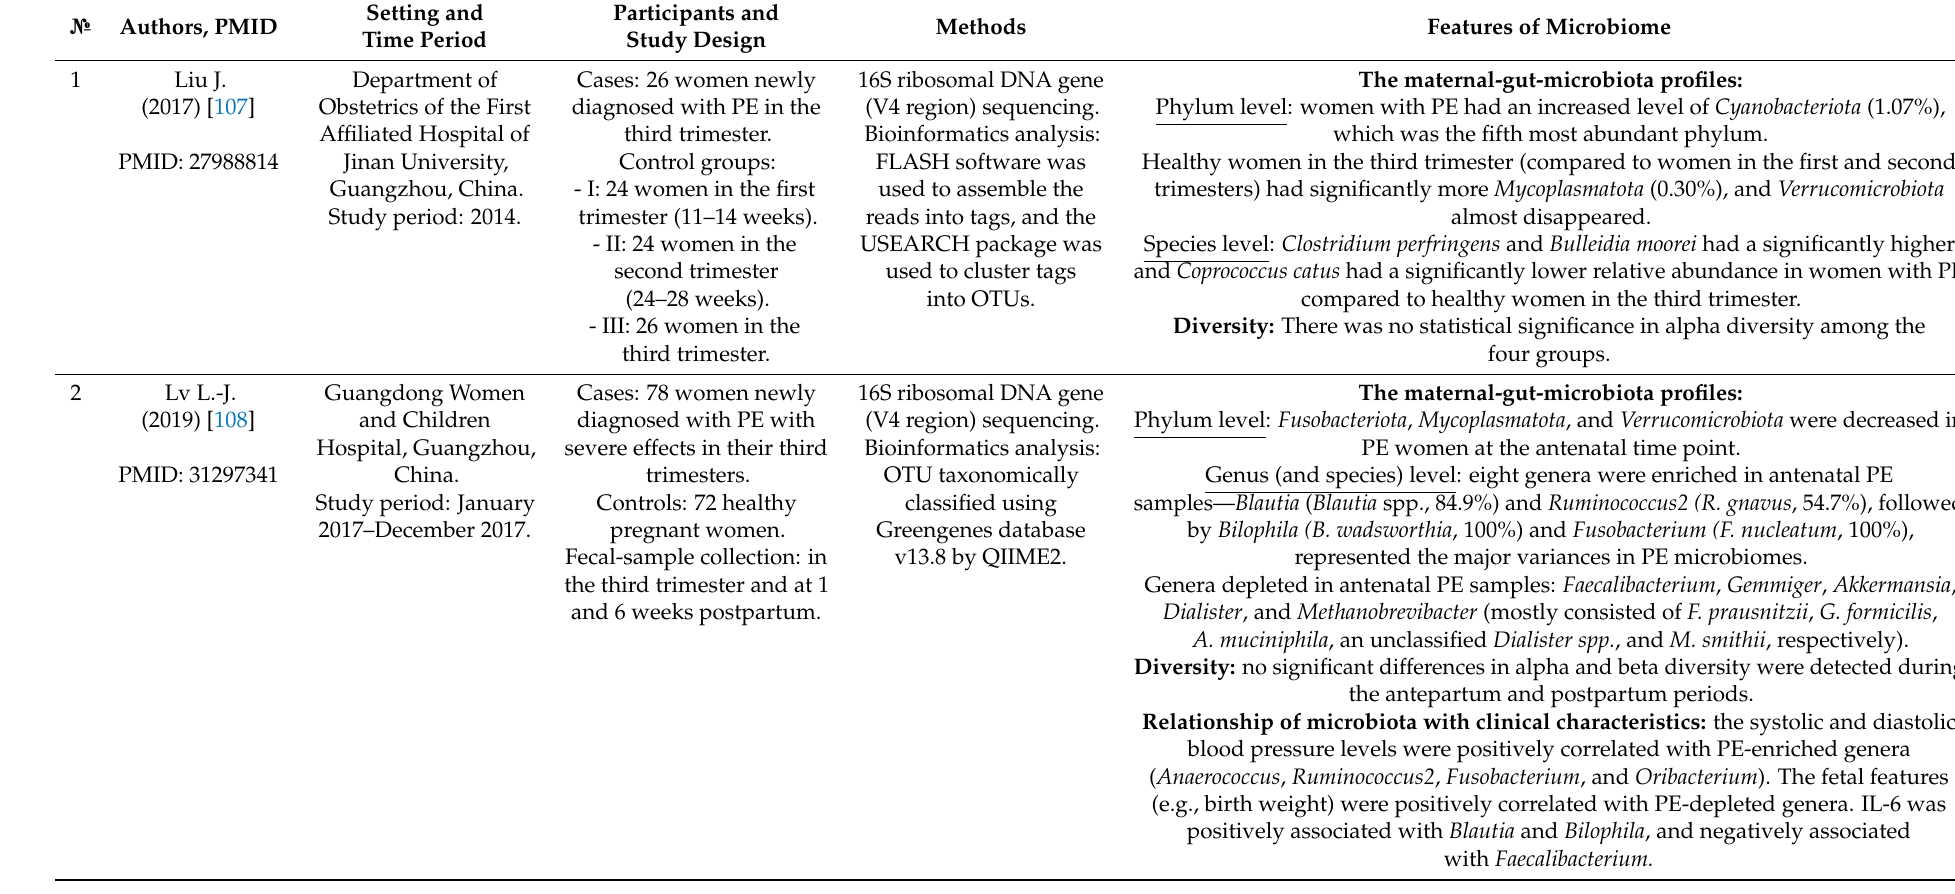
Table 3. Features of the intestinal microbiome in mothers with pre-eclampsia